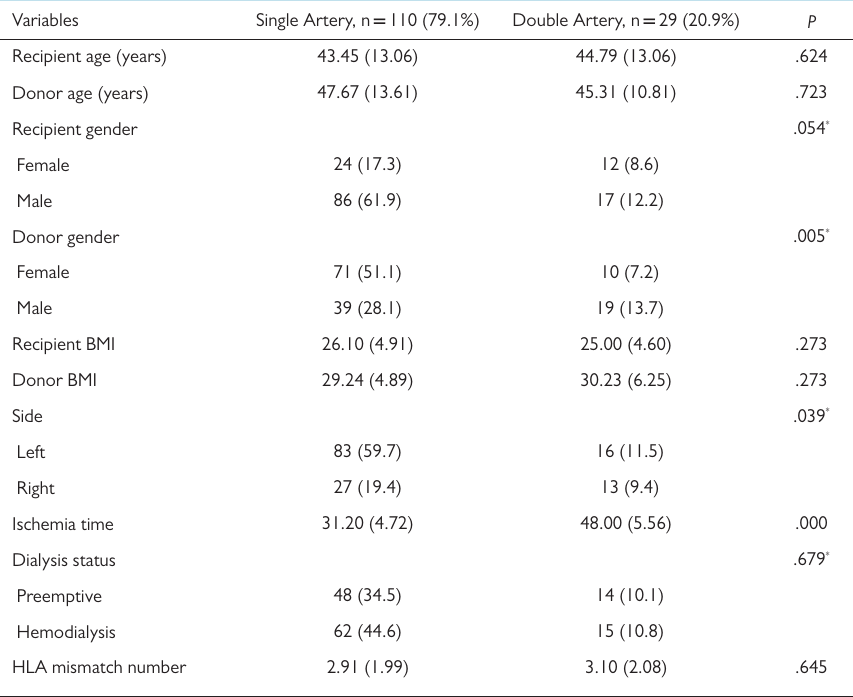
Table 2. Comparison Regarding Preoperative Characteristics and Operative Parameters (n = 139) Variables Single Artery, n = 110 (79.1%) Double Artery, n = 29 (20.9%)